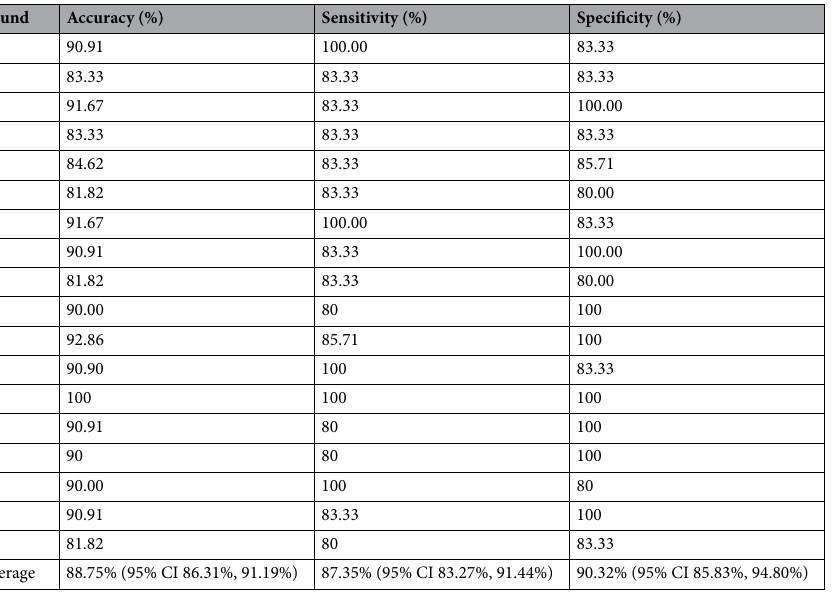
Table 4. The result of cross validation (TN vs.